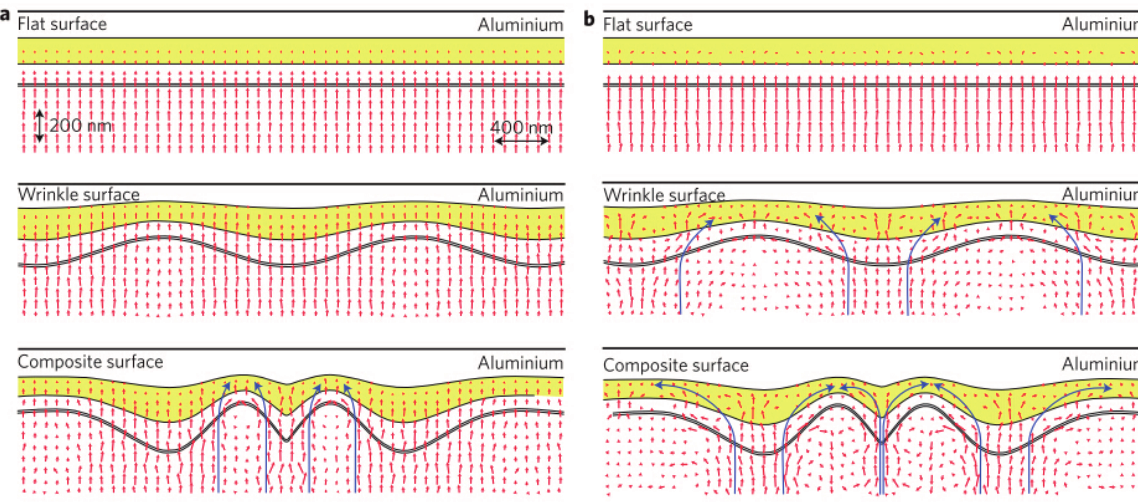
Figure 10. Photon flux diagrams of the optical stacks on flat, wrinkled and composite = 1.8 μ m and normal-incidence monochromatic illumination surfaces: ( a , b ) simulations for λ w at 488 nm ( a ) and 750 nm ( b ). Red arrows show the net photon flux and blue arrows illustrate large-scale flow. Incident light of a shorter wavelength (488 nm) is efficiently absorbed by the P3HT:PCBM active layer (shown in yellow), so the addition of wrinkles and folds has little effect on the optical path. In contrast, the flow of incident light of longer wavelength (750 nm) is altered significantly, with inplane light trapping leading to a dramatic enhancement in absorption. Cited from [97]. Copyright 2012,